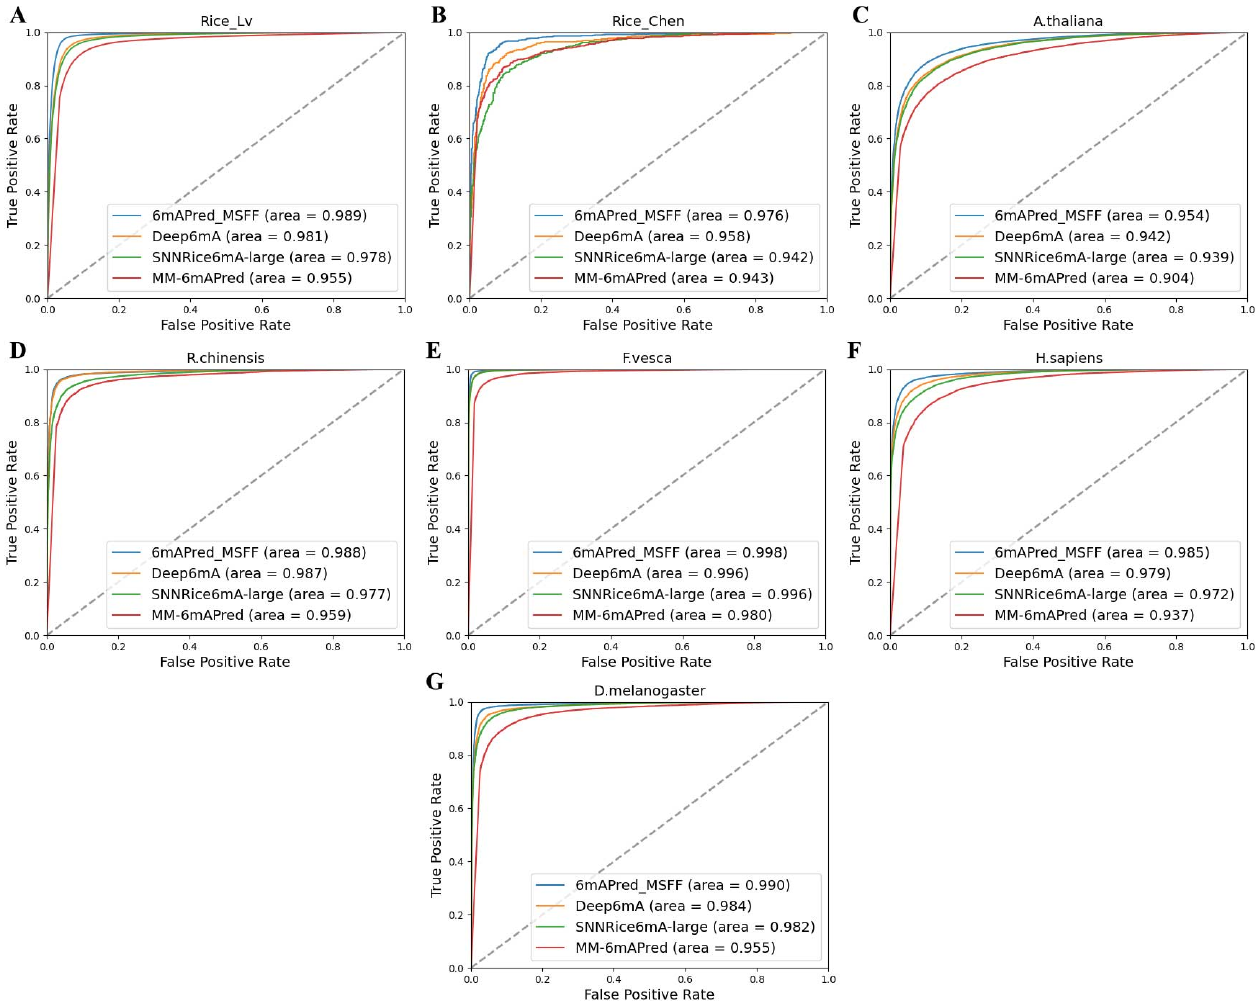
Figure 2. The ROC curves ( A – G ) of four models (6mAPred-MSFF, Deep6mA, SNNRice6mA-large, and MM-6mAPred) based on the seven datasets (6mA-rice-Lv, 6mA-rice-Chen, A. thaliana, R. chinensis, F. vesca, H. sapiens , and D. melanogaster ).